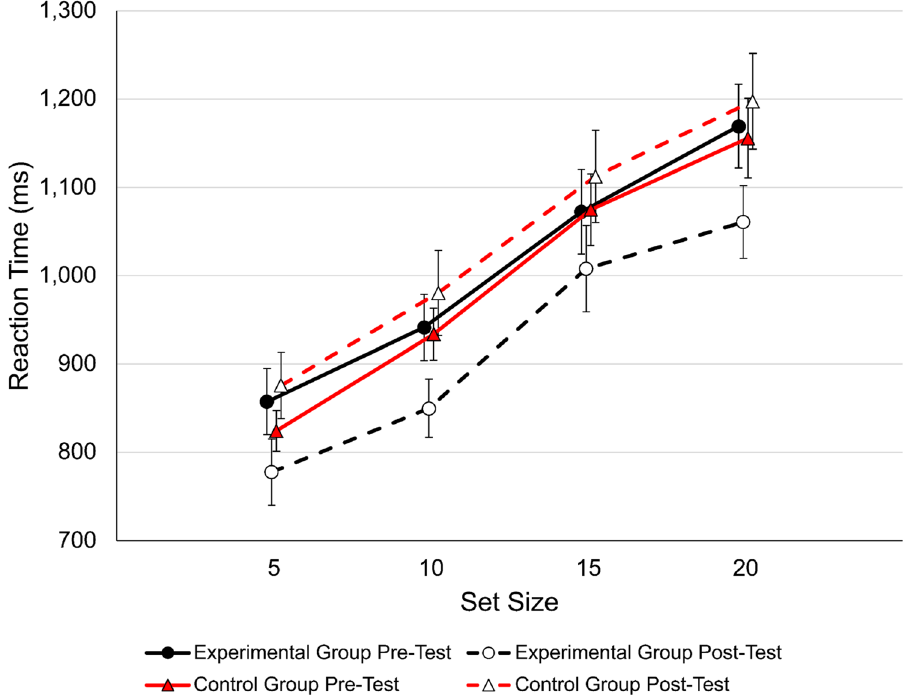
Figure 8. Reaction time data of the conjunction search task. The data show the typical slope that indicates how much longer it takes to find a target with an increasing number of distractors. While both groups performed similarly at pre-test, the experimental group improved at post-test and the control group got worse, although to a smaller degree. The averaged slope of fitted linear regression models to the actual reaction times at pre- test resulted in a value of 21.26 ms (SE = 1.40) which is well in line with previously reported data 40 . Error bars represent standard error of the